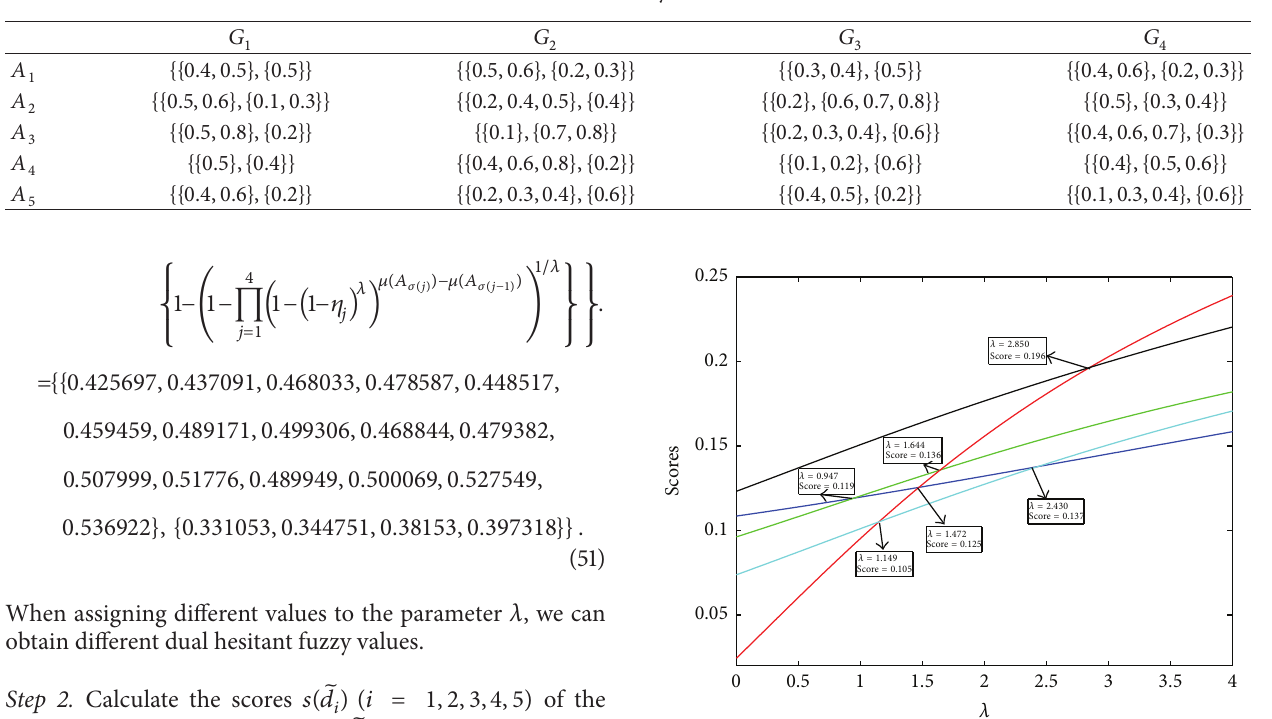
Table 1: Dual hesitant fuzzy decision matrix